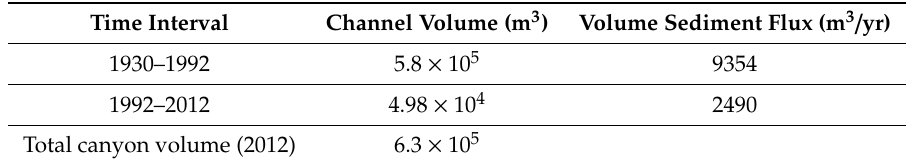
Table 2. Summary table of channel volume (m 3 ) and volume sediment flux (m 3 / yr) for channel corresponding to the 87- and 10-year time intervals from 1930 to 1992 and from 1992 to 2012,